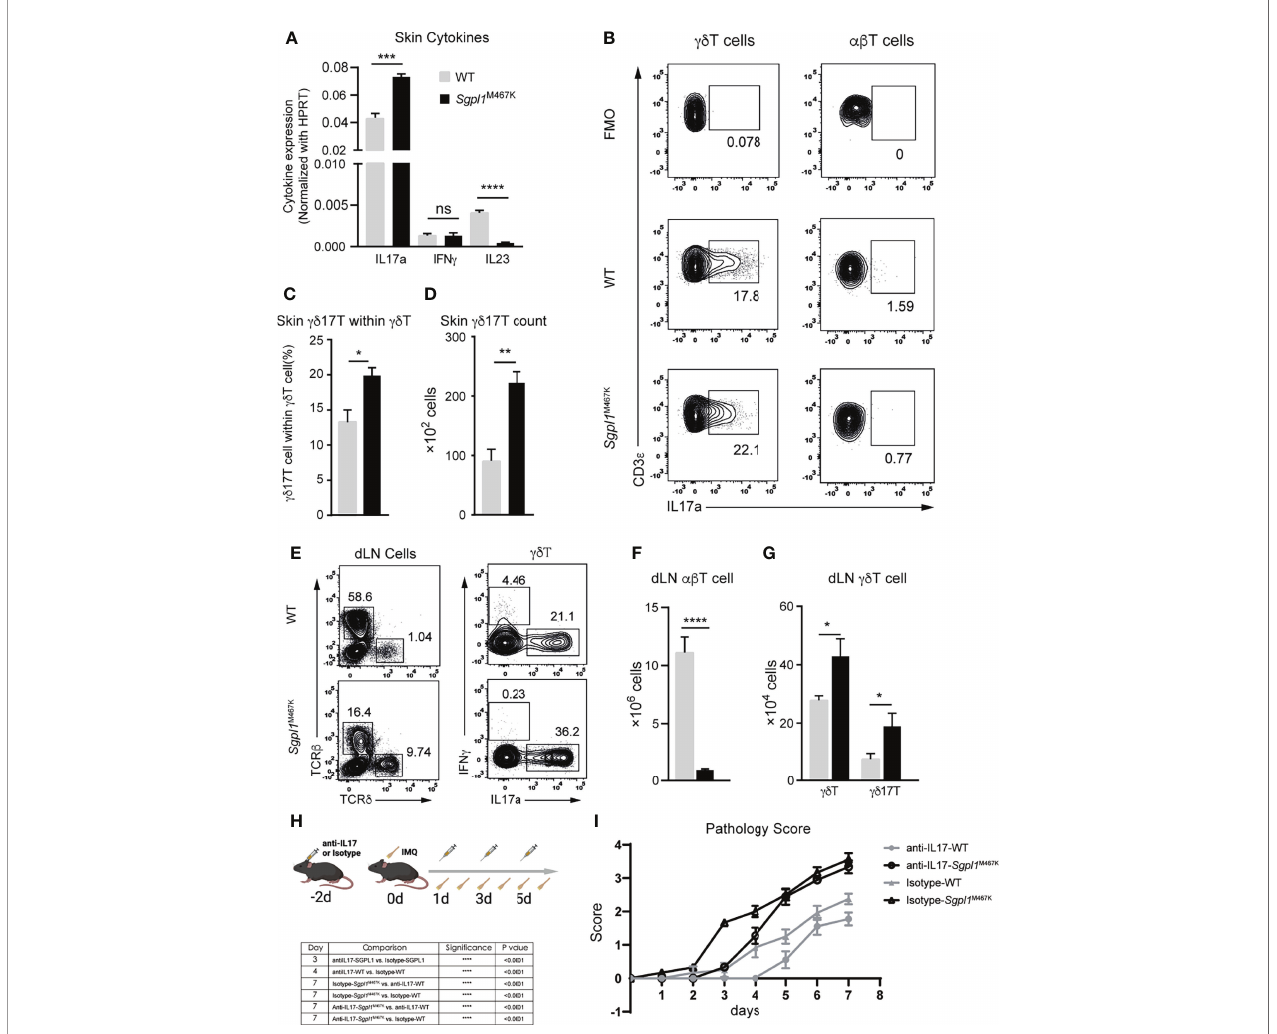
FIGURE 5 | Elevated levels of IL17a + cells contributed to IMQ-induced acute pathology in Sgpl1 M467K skin lesions. (A) Cytokine expression within psoriatic lesions was measured with quantitative PCR 7 days after IMQ treatment. The experiment was conducted two times. (B – D) Lesional gd 17T count after 7 days after IMQ induction was determined with fl ow cytometer; (b) representative fl ow cytometer fi gure for gd 7T cell or IL17 + ab T cell population. (C) gd 17T proportion within the gd T population; (D) gd 17T cell counts within the skin lesion. (E – G) Draining LN cell count after 6 days of IMQ treatment determined by fl ow cytometer. (E) Representative fl ow cytometer fi gure; left, total draining LN cells were sub-grouped to ab T cells and gd T cells; right, gd T cells were tested for IFN g or IL17a expression. (F, G) ab T cell, gd T, and gd 17T cell count within draining LN. For both skin and its draining LN analysis, data were pooled from two experiments, which analyzed fi ve wild-type and six mutants; ****, p<0.0001; ***, p<0.001; **, p<0.01; *, p<0.05; ns, not signi fi cant; unpaired t-test. (H, I) IL17 neutralization postponed pathology progression on IMQ treated Sgpl1 M467K skin; (H) experiment fl ow-chart, IL17 antibodies or Isotype antibodies were administrated at days -2, 1,3, and 5; IMQ was painted on mouse ears from day 0 to day 6; (I) Pathology score was determined by ear thickness, erythema, and scaling score from day 0 to day 7; the statistical analysis is listed on the left table; similar results were obtained from two repeated experiments; analyzed with two-way